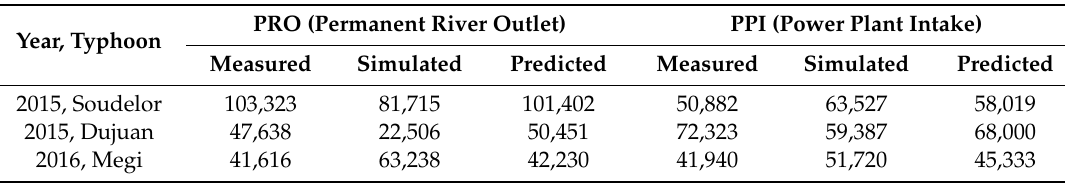
Table 2. Comparison of the measured, simulated, and predicted release amount of bottom outlets during typhoons from 2015 to 2016.